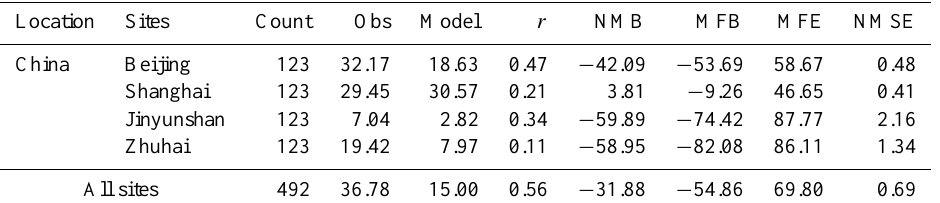
Table 6. Statistical performance of WRF-Chem–REAS simulations for NO 2 in 2007. The unit of Obs and Model is ppbv. Other statistical indicators and associated units are described in Table 2.